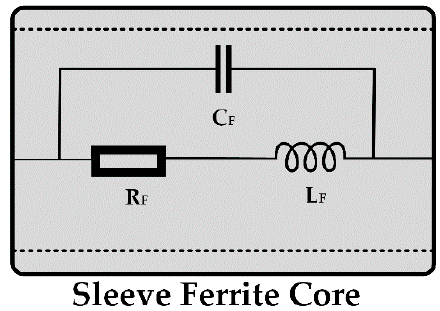
Figure 5. Simplified sleeve ferrite core equivalent circuit.